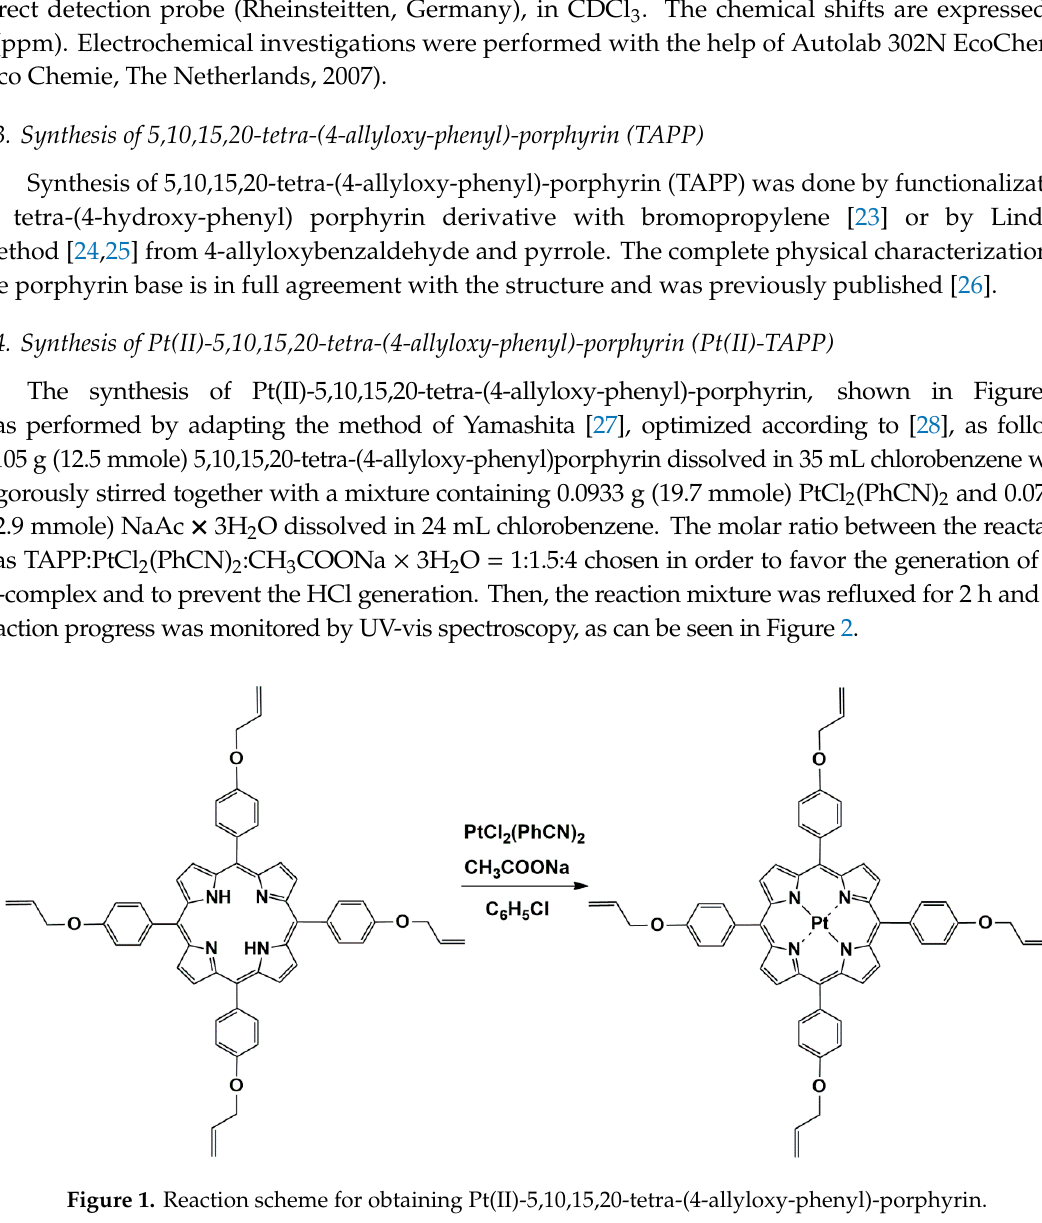
Figure 1. Reaction scheme for obtaining Pt(II)-5,10,15,20-tetra-(4-allyloxy-phenyl)-porphyrin.